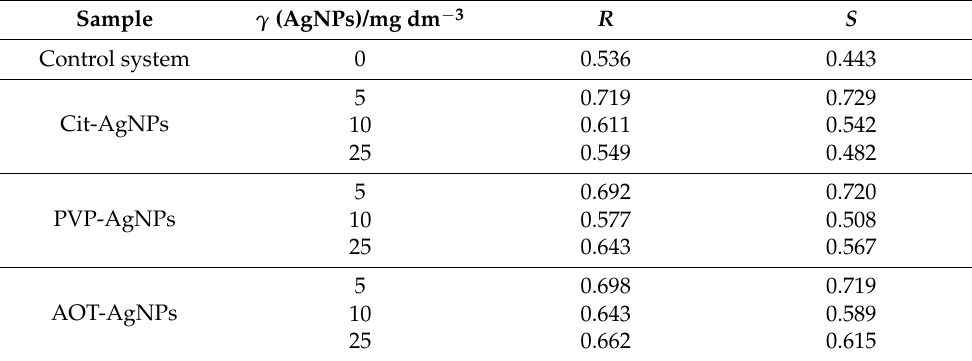
Table 2. R - and S -values of the powdered irradiated precipitates obtained after 60 min reaction time in the presence of different concentrations of silver nanoparticles (AgNPs) stabilized with citrate (cit-AgNPs), poly(vinylpyrrolidone) (PVP-AgNPs), and sodium bis(2-ethylhexyl) sulfosuccinate (AOT-AgNPs). c (CaCl 2 ) = c (Na 2 HPO 4 ) = 4 · 10 − 3 mol dm − 3 , pH 7.4, 25 ◦